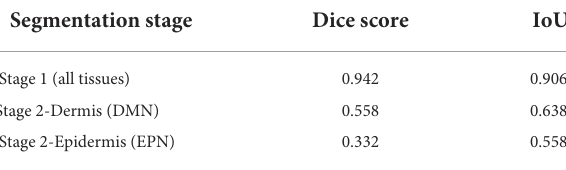
TABLE 3 Evaluation of the segmentation model on ROI testing set (This table appeared in Nofallah et al.,